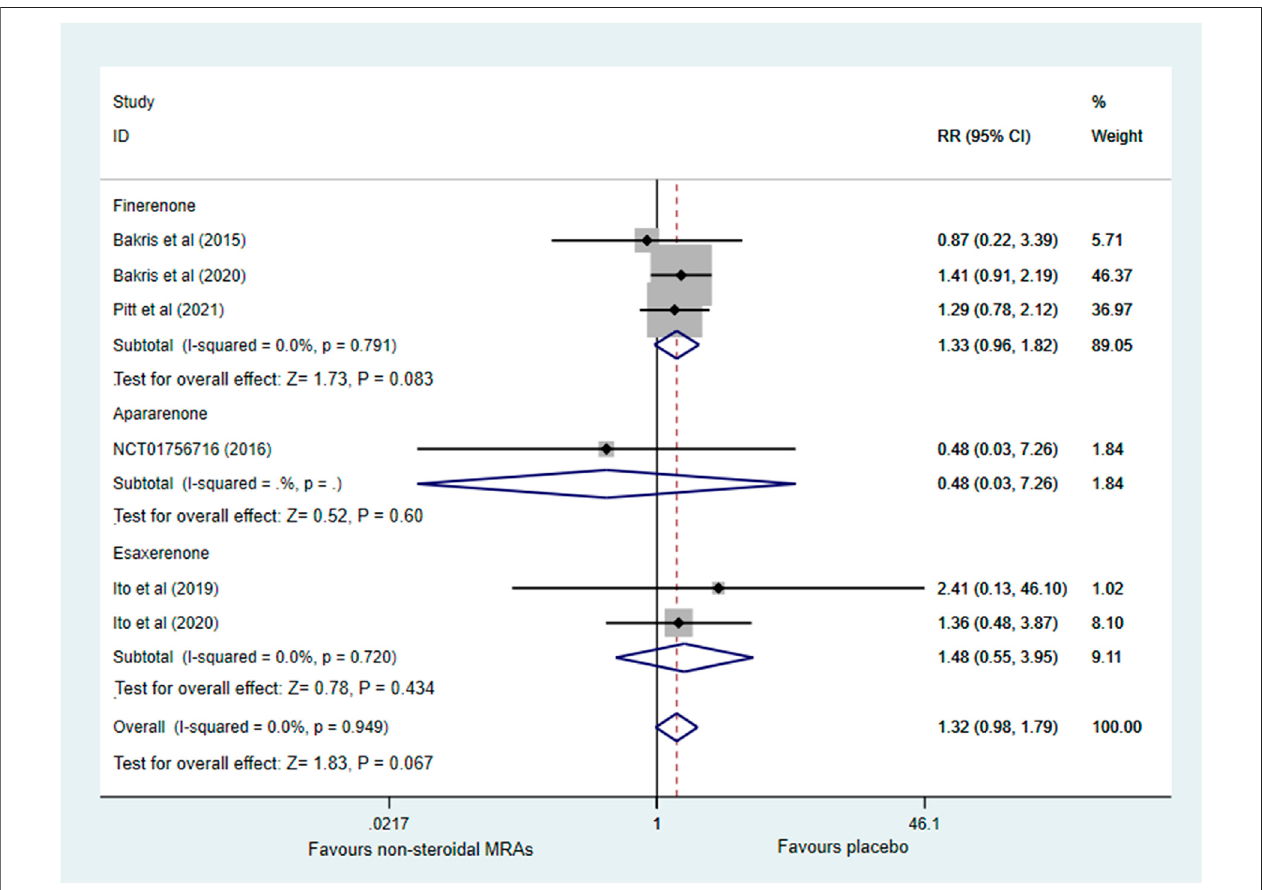
FIGURE 7 | Forest plot for the effect of non-steroidal MRAs on the incidence of serious adverse events in patients with CKD and T2D. RR, risk ratio; MRAs, mineralocorticoid receptor antagonists; CKD, chronic kidney disease; T2D, type 2 diabetes.